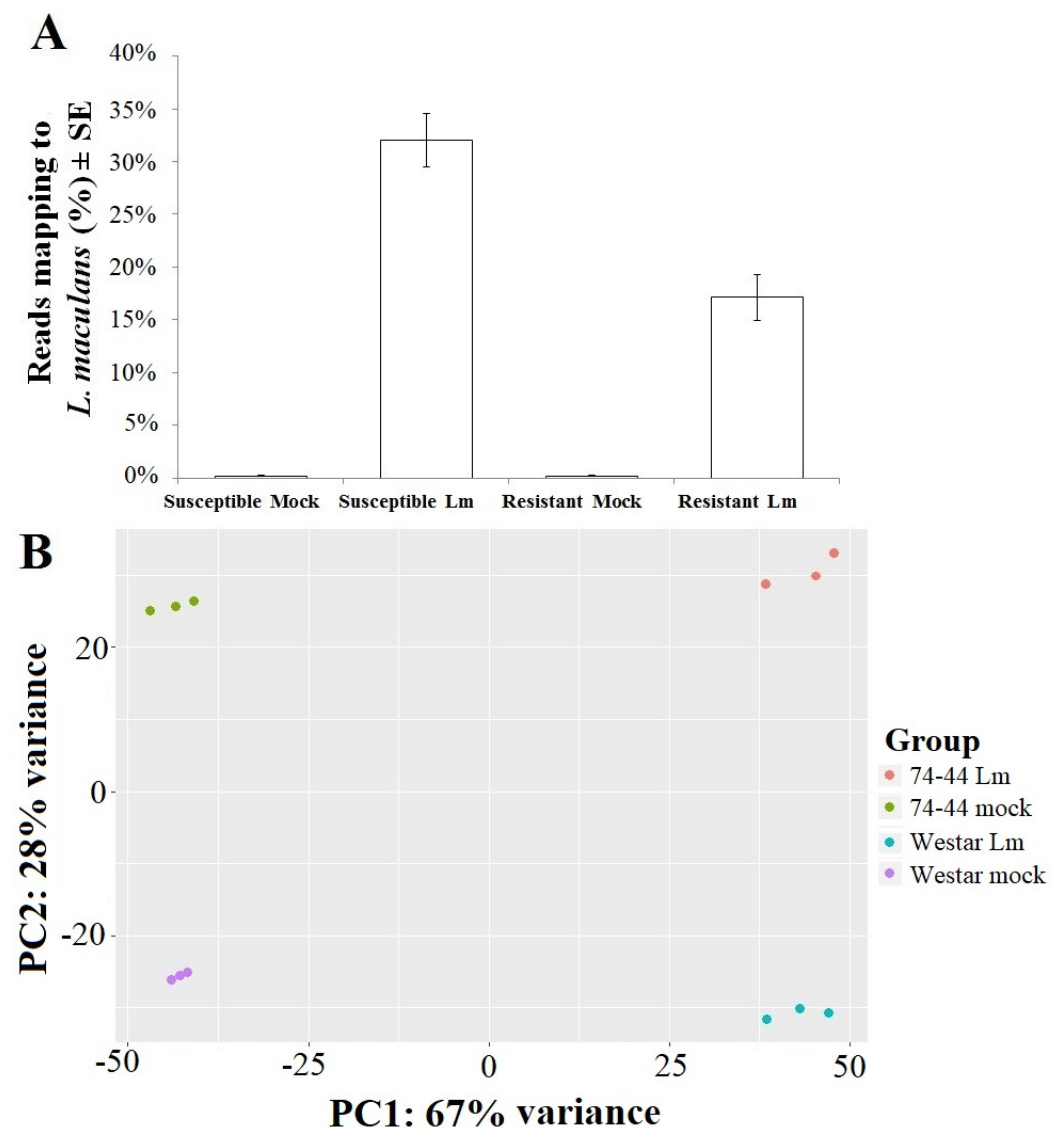
Figure 2. Percent of reads mapped to the Lm genome ( A ) and principle-component-analysis (PCA) plot, produced by DESeq2 ( B ).